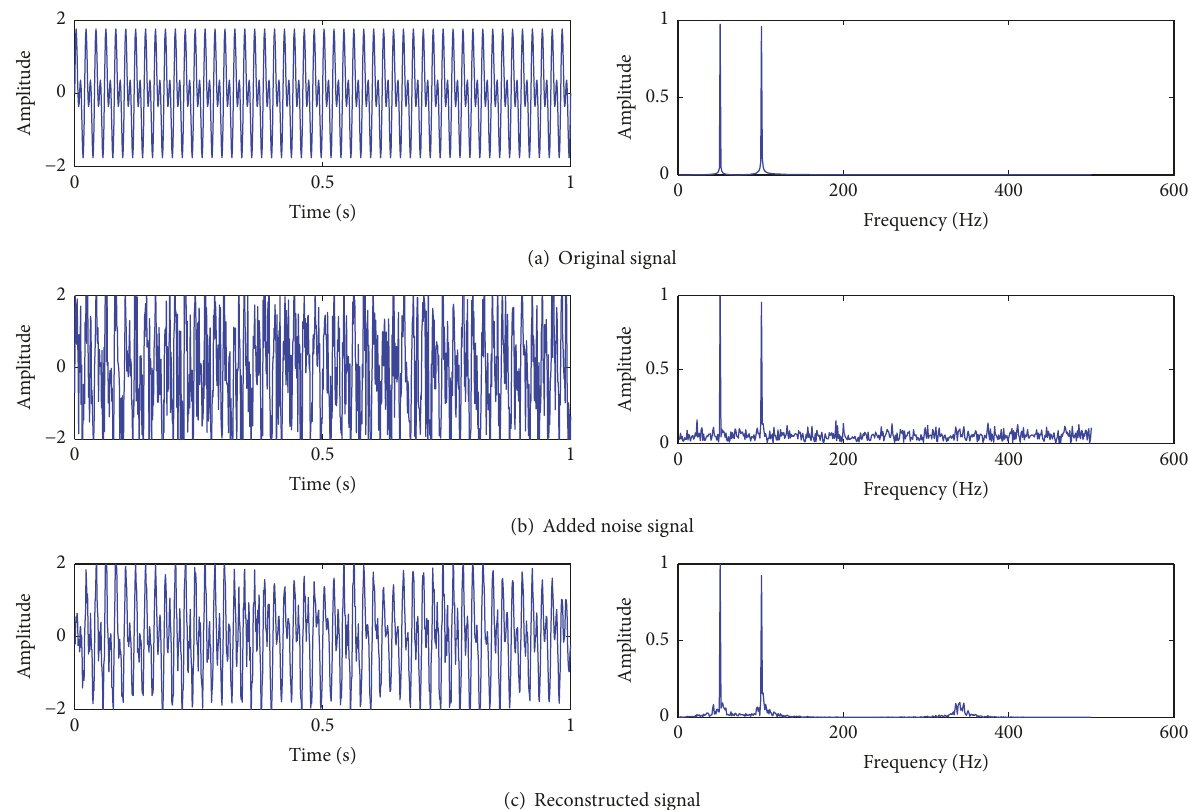
Figure 4: The filtering characteristics of VMD.